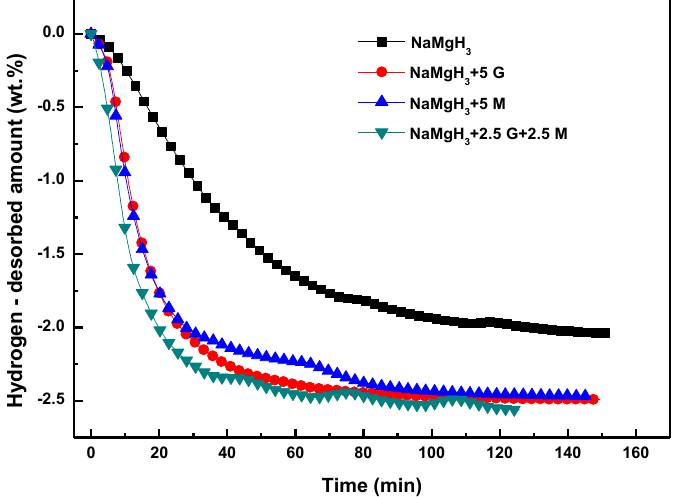
Figure 5. Dehydriding kinetic curves of the NaMgH 3 hydride and the NH-CM composites at 613 K.